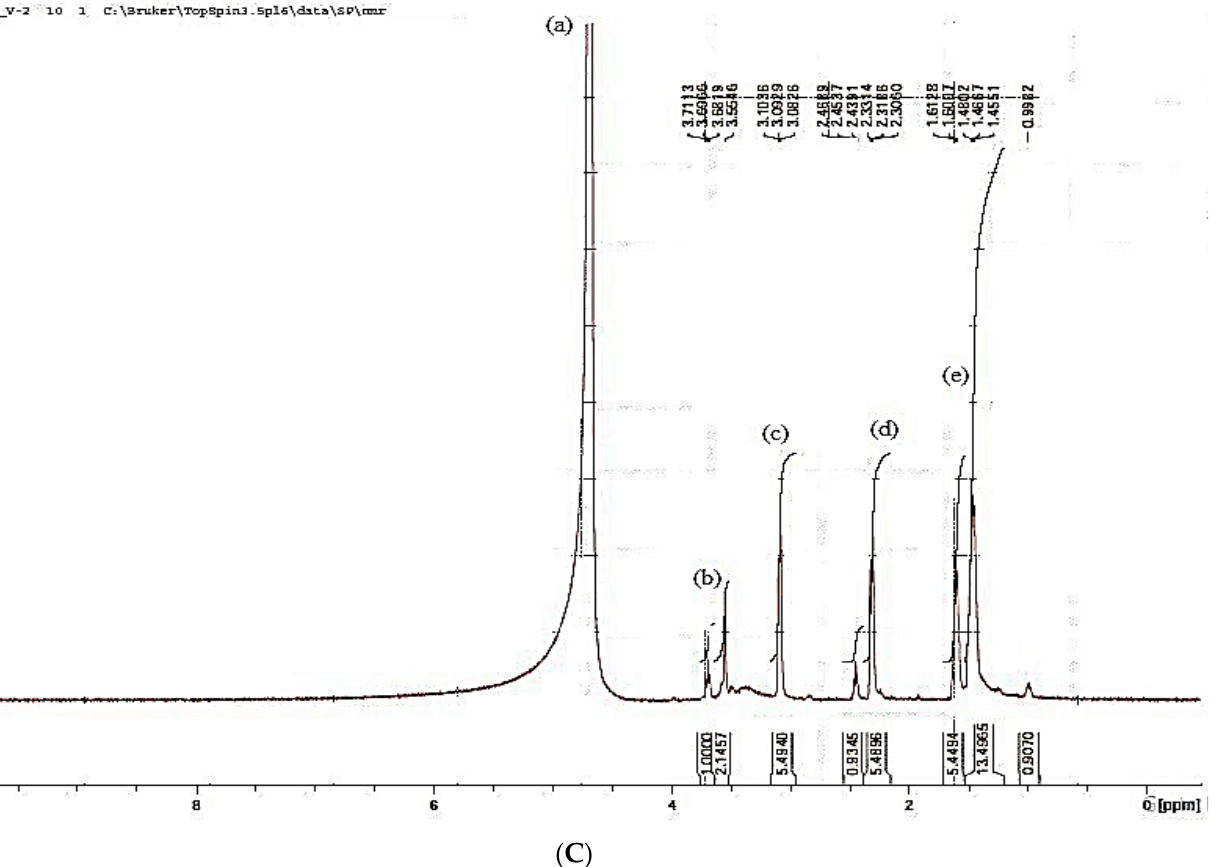
Figure 1. 1 H-NMR spectrum analysis of ( A ) pure N-vinylcaprolactam, ( B ) sodium alginate, and ( C ) Poly (NVCL-g-NaAlg) sample.